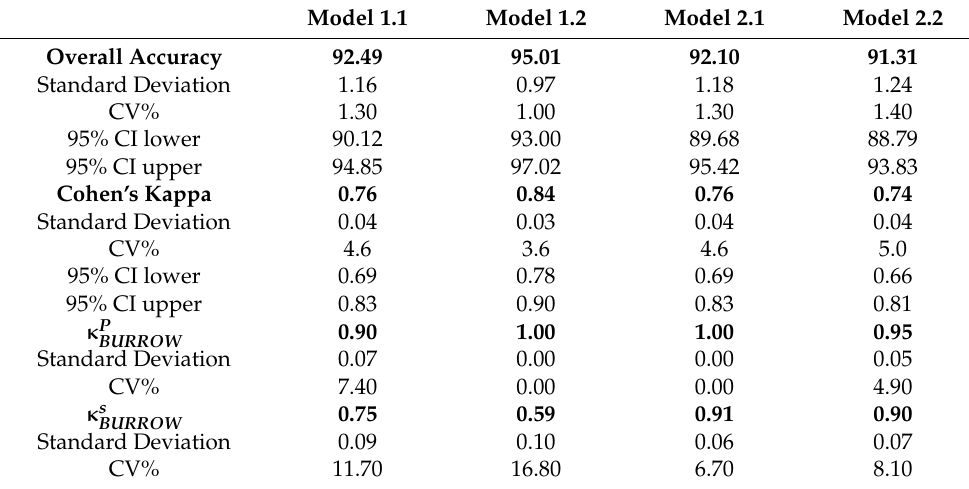
Table 2. Overall accuracies and kappa statistics, per-class BURROW kappa for S ( κ s P ( κ P ), and their parameter estimates for each RF model. Coefficient of variation (CV%), BURROW confidence interval